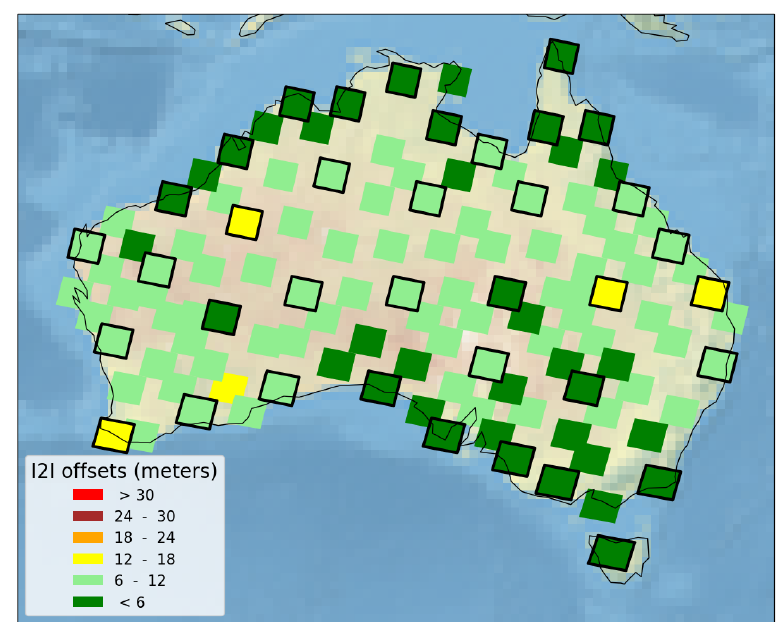
Figure 6. Residual offsets between Landsat 8 orthorectified products using GLS GCPs after free triangulation adjustment and the AGRI reference data using the image-to-image (I2I) characterization procedure. The anchor sites are indicated by black outline. Note that by using the free adjustment triangulation, most of the sites are within 12 m with respect to the AGRI reference even without using the AGRI control in the triangulation.